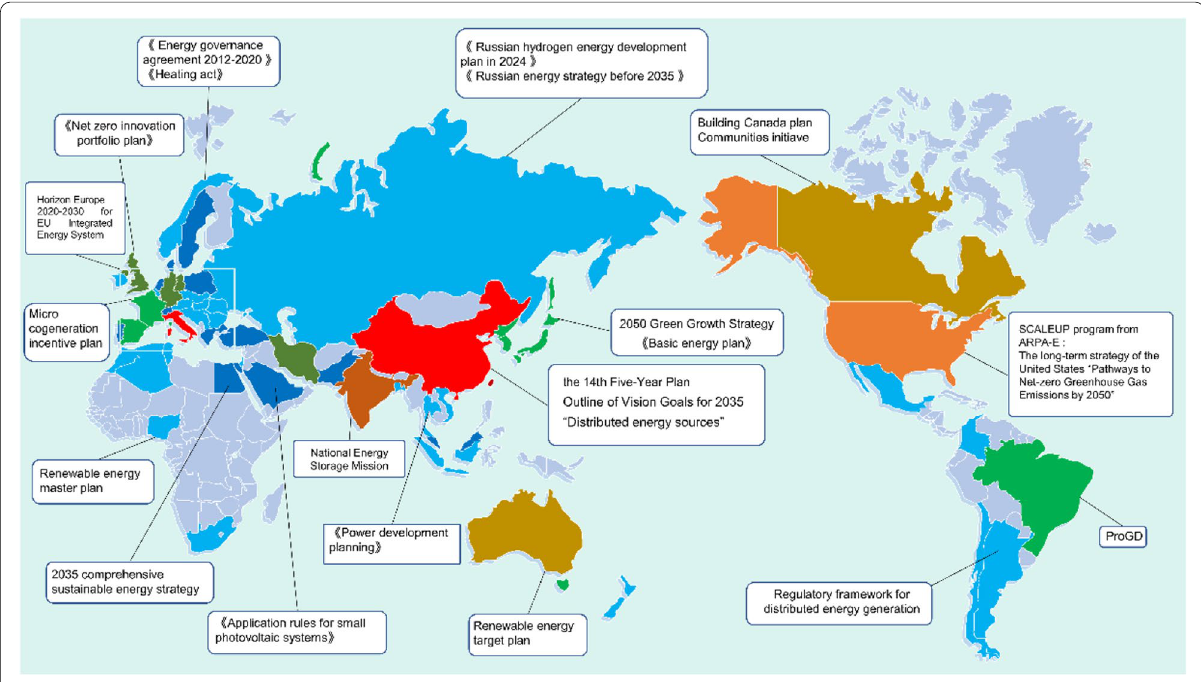
Fig. 2 Policies of different countries on energy